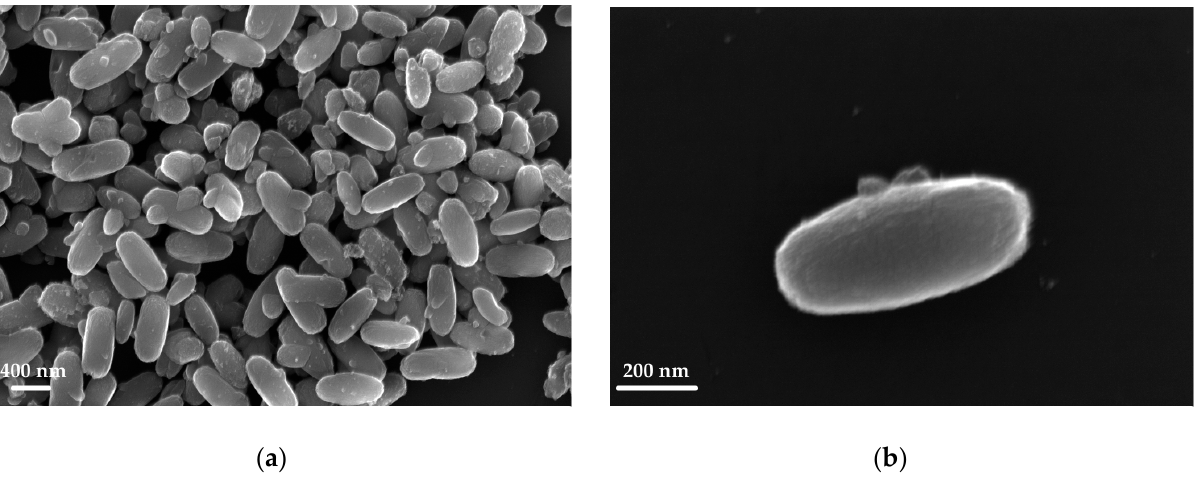
Figure 2. SEM image of the TP22.10 sample ( a , b ) zoomed in on a single small particle.